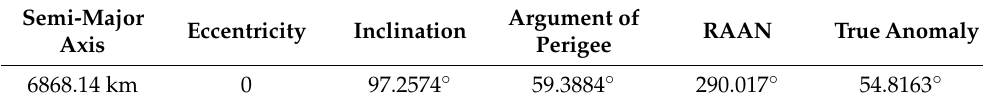
Table 5. Initial orbital elements.